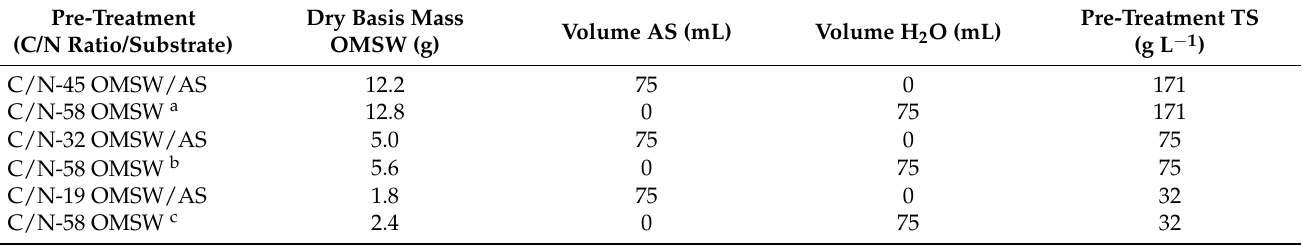
Table 2. Mixture conditions for pre-treatment of Olive mill solid waste and Aquaculture sludge at the same TS